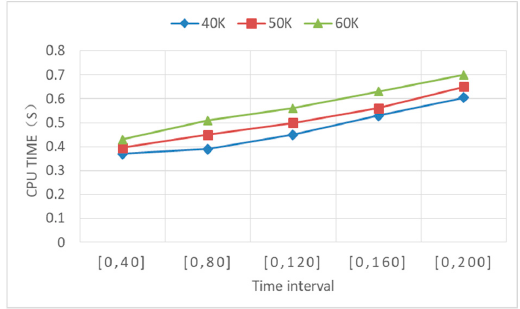
Figure 13. Effect of different time intervals on performance. Figure 11. E ff ect of di ff erent time intervals on Figure 10. The number of objects in local road networks varies with the number of moving objects in different time intervals.